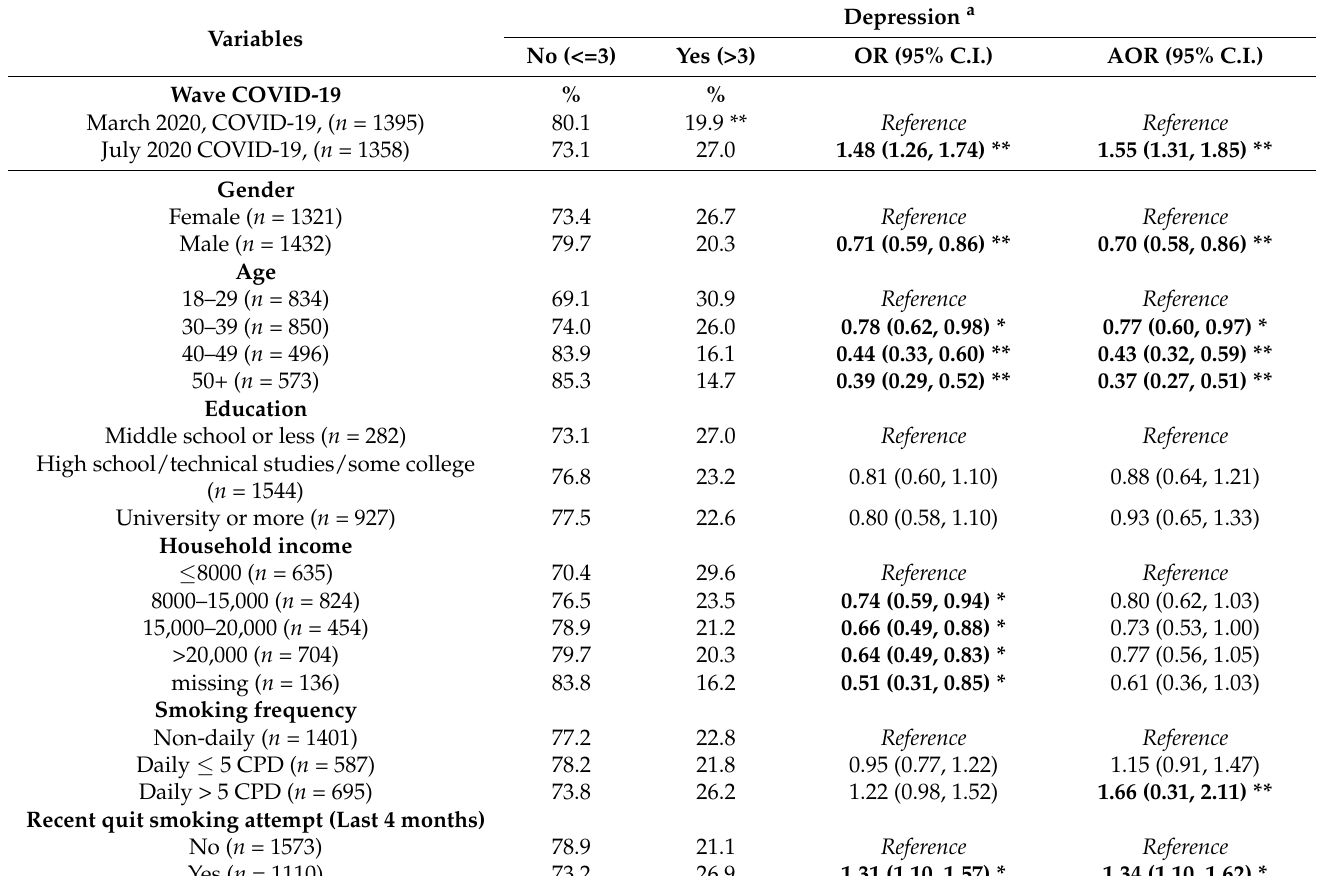
The results for perceived stress are shown in Table 3. The mean perceived stress